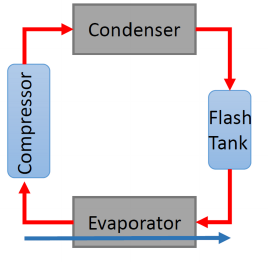
Figure 4. Schematic representation of a cooling unit